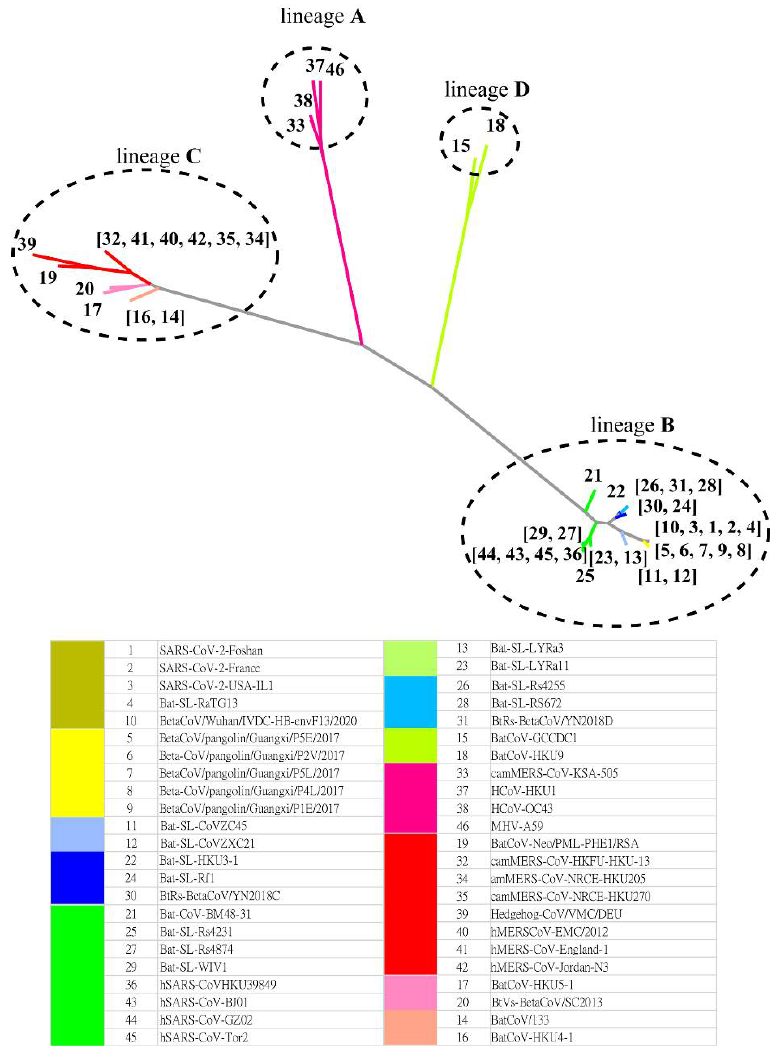
Figure 4. A character-based phylogenetic tree of the beta coronavirus network, as constructed by IQ-TREE with the WAG+F+R4 model. The numbers in the tree diagram refer to the coronavirus sequences in the legend.